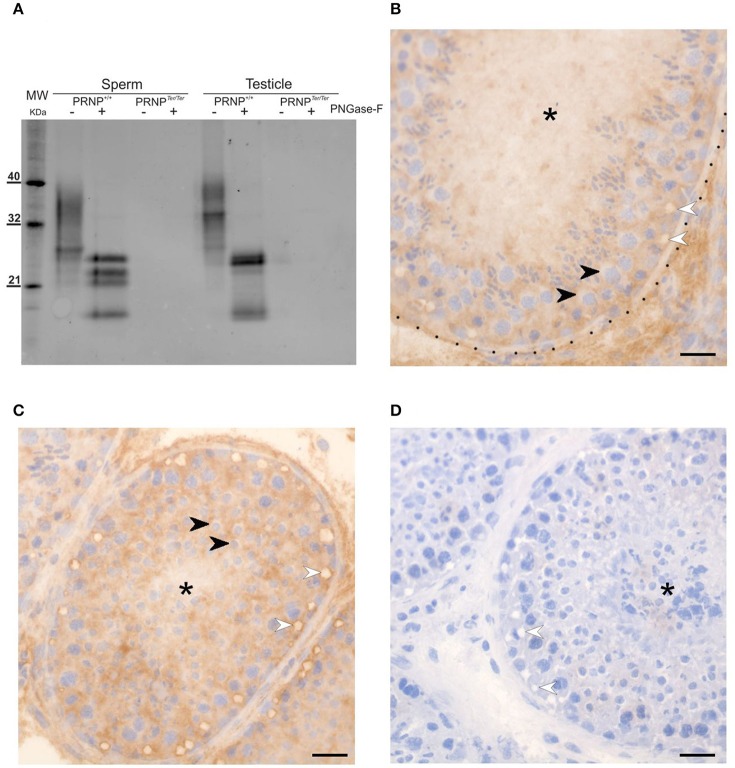
PrPC is expressed in testicular tissue and spermatozoa. PrPC was detected in testicle and spermatozoa by Western blot (WB) (A) and Immunohistochemistry (IHC) (B–D) using the P4 and 6H4 antibodies, respectively. In WB (A), glycosylated full-length PrPC is detected in both spermatozoa and testicular tissue. After deglycosylation with PNGaseF, several bands are visible on both preparations, including bands of approximately 25 and 18 kDa molecular mass, probably corresponding to full length PrPC and a C-terminal fragment, respectively. Further bands with apparent molecular mass of 22–24 kDa are particularly prominent in samples from spermatozoa. No PrPC could be detected in samples from PRNPTer/Ter animals. By IHC, a distinct PrPC staining of seminiferous tubules with positive Sertoli cells, including the rim of vacuoles (white arrowheads) was observed. Spermatocytes (B) black arrowheads, and round spermatids (C) black arrowheads appeared negative for PrPC. Testicular tissue from PRNPTer/Ter bucks (D) are completely unstained, but similar in architecture and the presence of vacuoles (white arrowheads). The basement membrane of seminiferous tubules is indicated by dots, and the lumen by asterisk. (B–D): x400. Scale bars 25 μm.